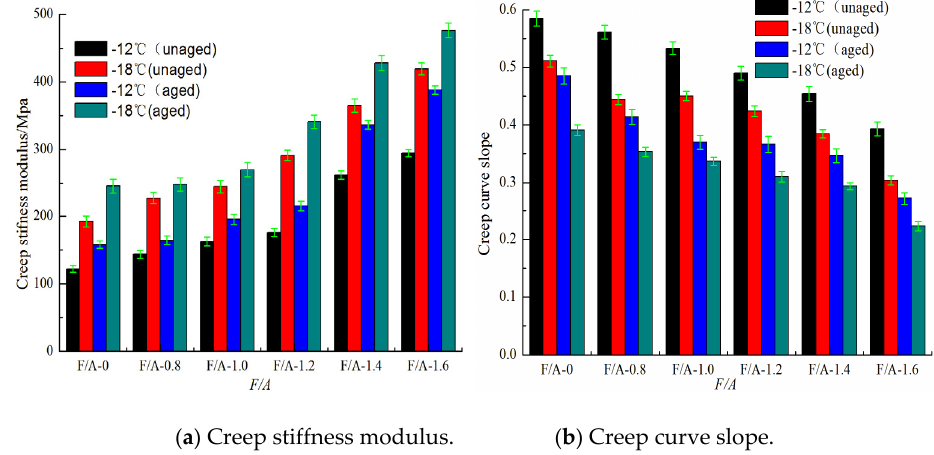
Figure 14. Low-temperature performance evaluation parameters of modified asphalt mortar.